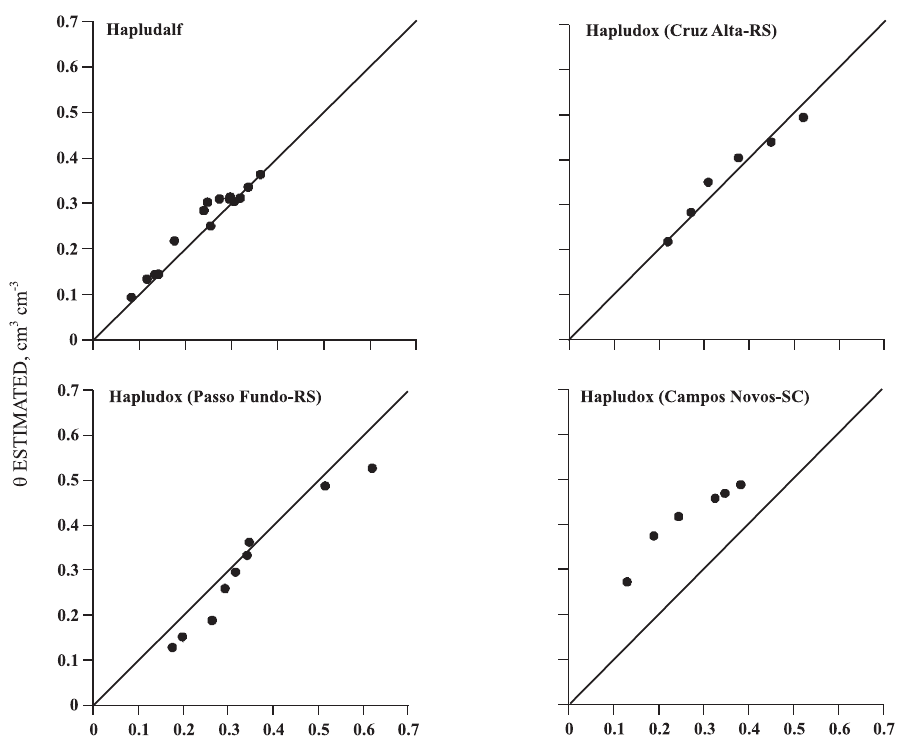
Figure 9. Relationship (1:1 graphic) between the volumetric soil moisture observed and that estimated with the model proposed by Topp et al. (1980).